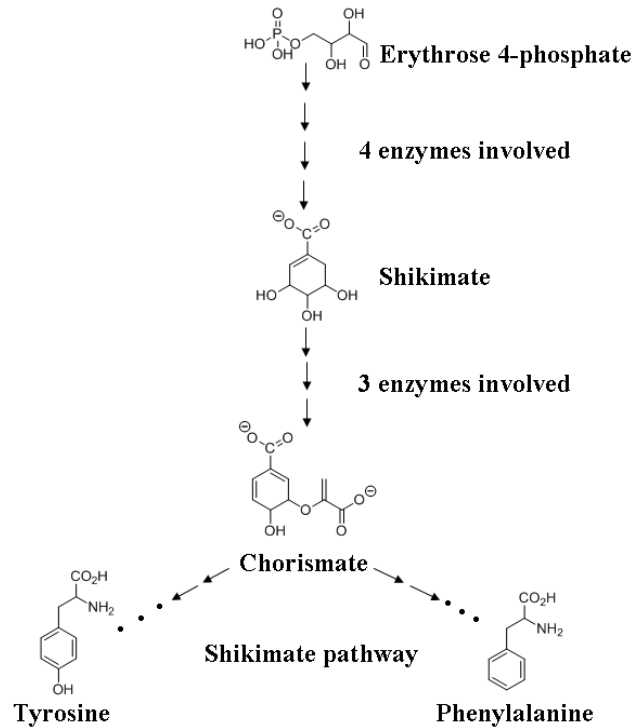
Figure 2. Overview of the shikimate pathway for the biosynthesis of phenylalanine and